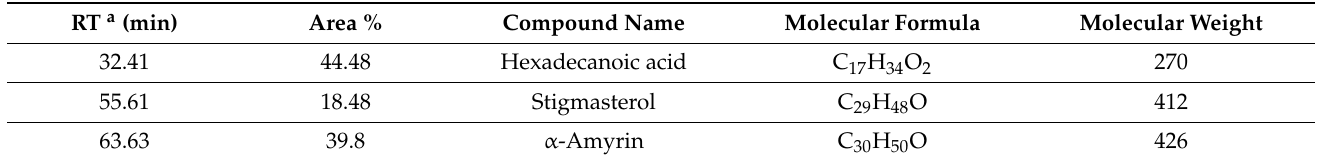
Table 3. Identification of metabolites components produced by Streptomyces sp. strain CALT_2 using gas chromatography–mass spectrometry (GC–MS) analysis.